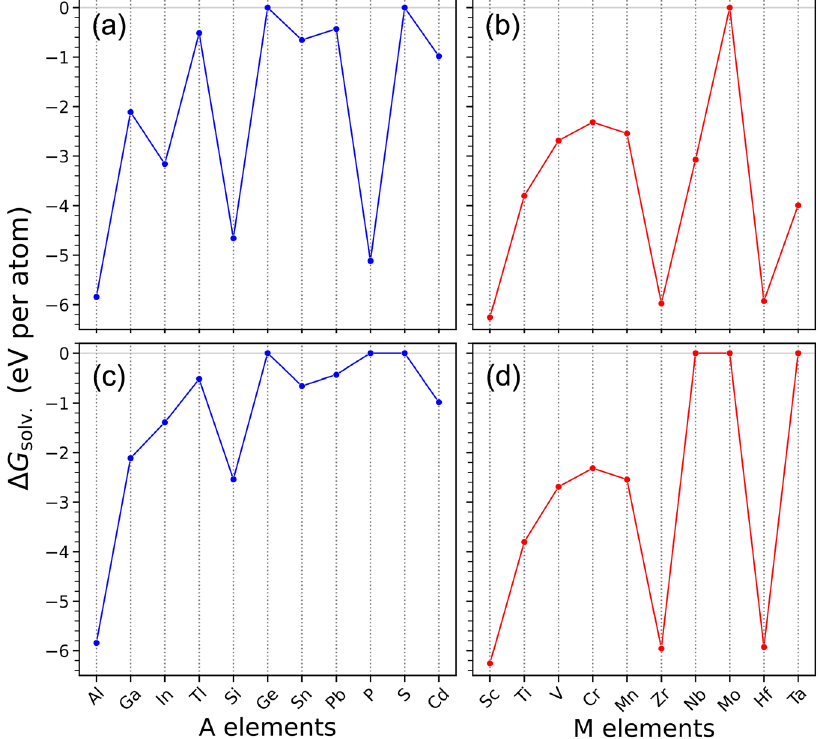
Fig. 4 Comparison of the solvation of A and M elements. Solvation free energies of A ( a , c ) and M ( b , d ) elements with respect to their elemental reference bulk phases, when calculated without restrictions on allowed ions and molecules ( a , b ) and with the constraint the oxygen-containing species are not considered ( c , d ). A solvation energy of zero means that the reference state is stable against solvation. Calculated for pH = 0 and an ion concentration of 10 − 3 mol dm − 3